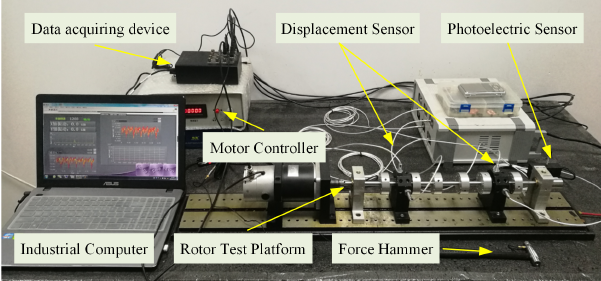
Figure 6. Experimental rotor test